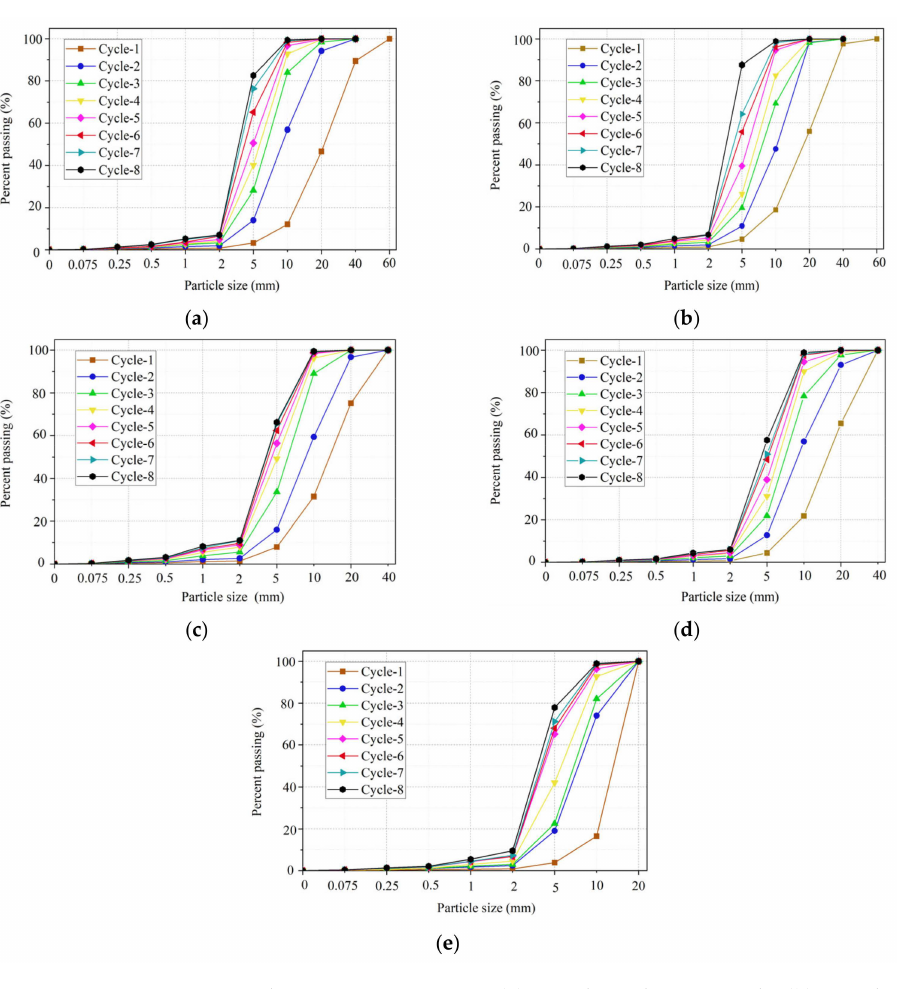
Figure 7. Particle size variation curve: ( a ) sample 1# dry–wet cycle; ( b ) sample 2# dry–wet cycle; ( c )